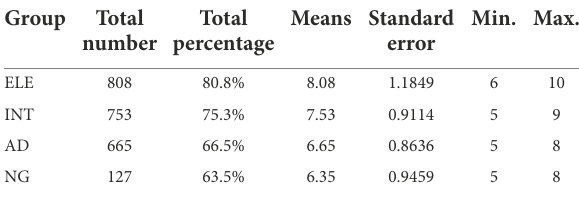
TABLE 2 Production results of existential